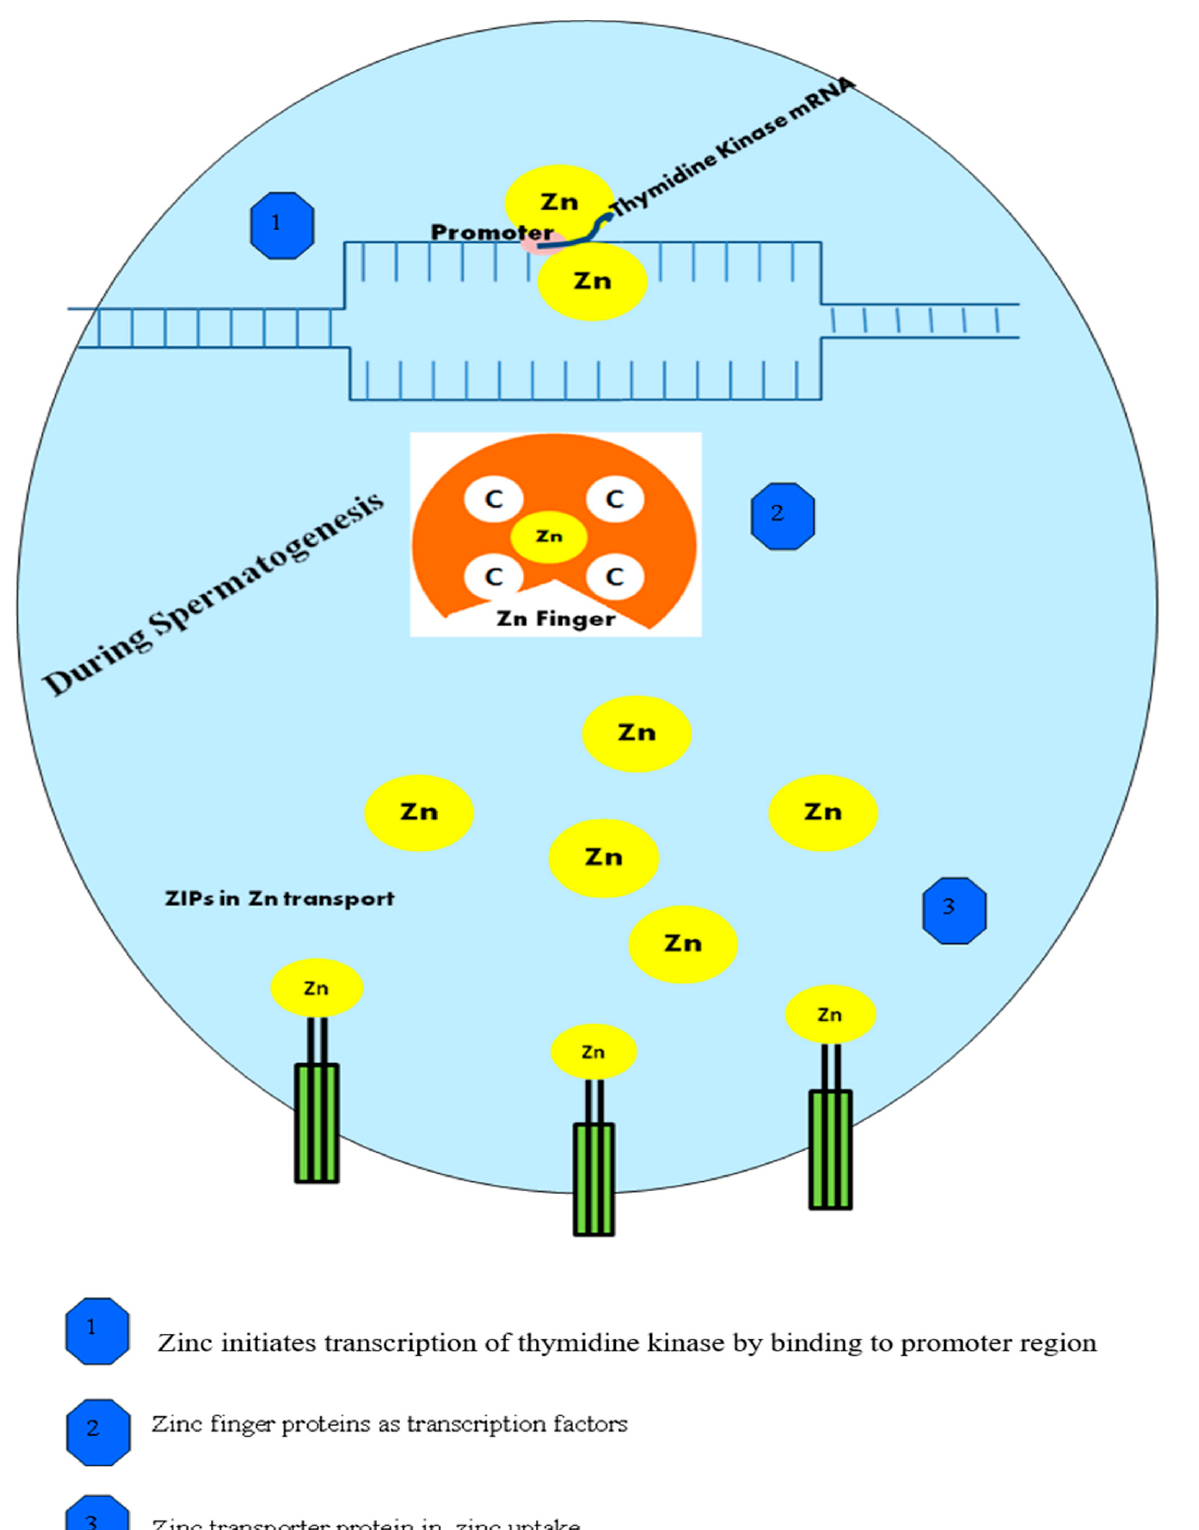
Figure 1. ZIPs (the zinc-regulated transporters, iron-regulated transporter-like proteins). The role of zinc (Zn) during spermatogenesis at the molecular level. The figure depicts how Zn initiates the transcription of kinase, Zn finger proteins as transcription factors, and the Zn uptake process during spermatogenesis.